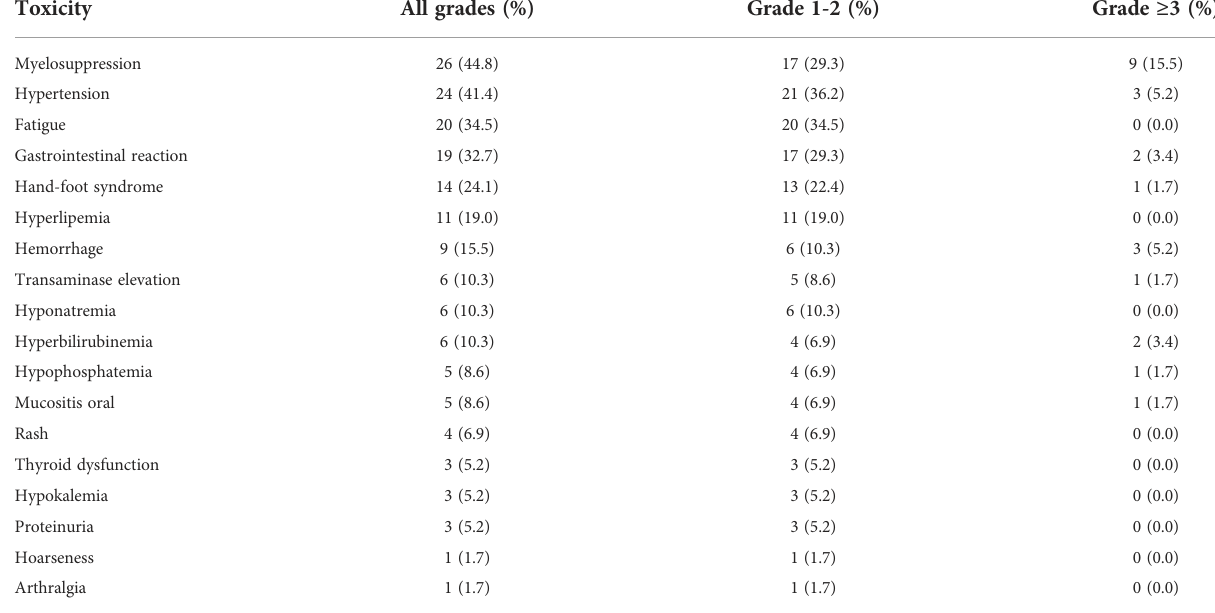
TABLE 6 Summary of adverse